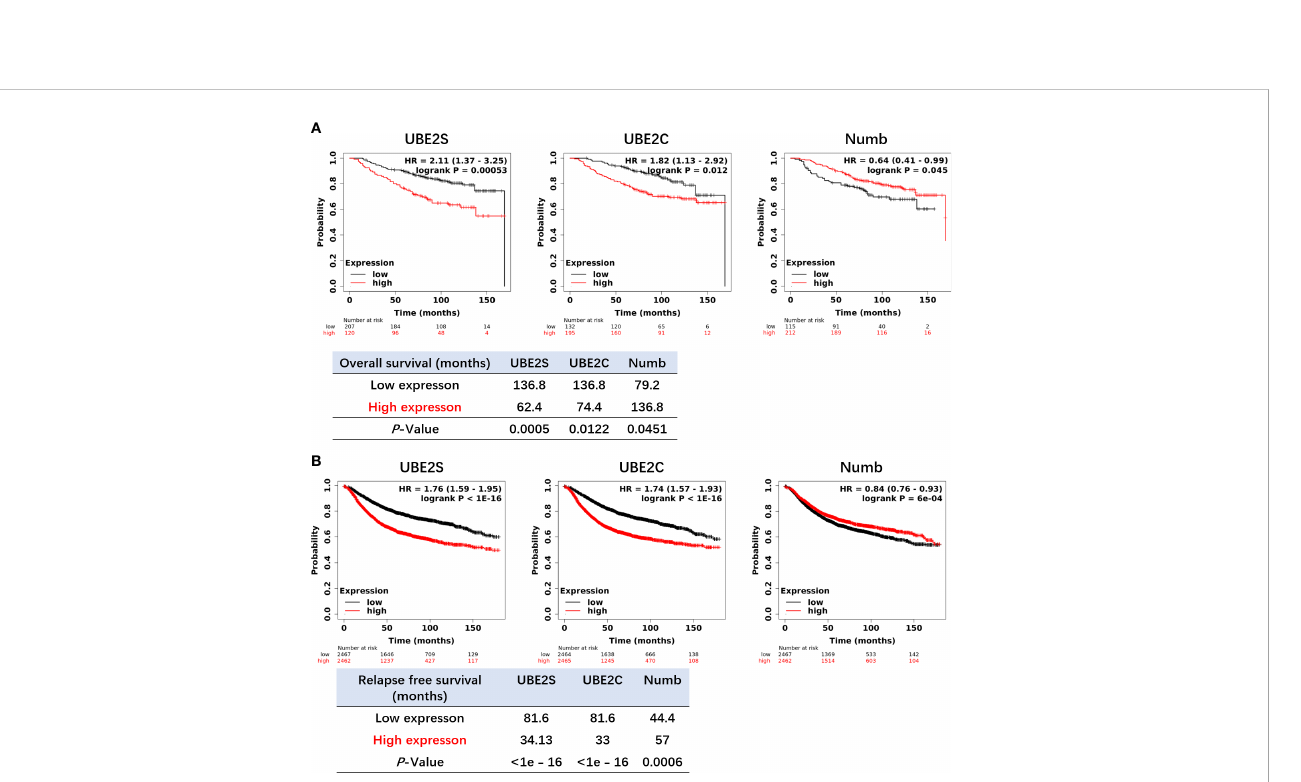
FIGURE 6 Higher levels of UBE2S and UBE2C and a lower level of NUMB correlate with shorter OS (A) and RFS (B) in breast cancer patients by the Kaplan – Meier plotter survival analysis. OS, Overall Survival. RFS, Relapse-Free Survival. The p -value and survival time were indicated in the respective